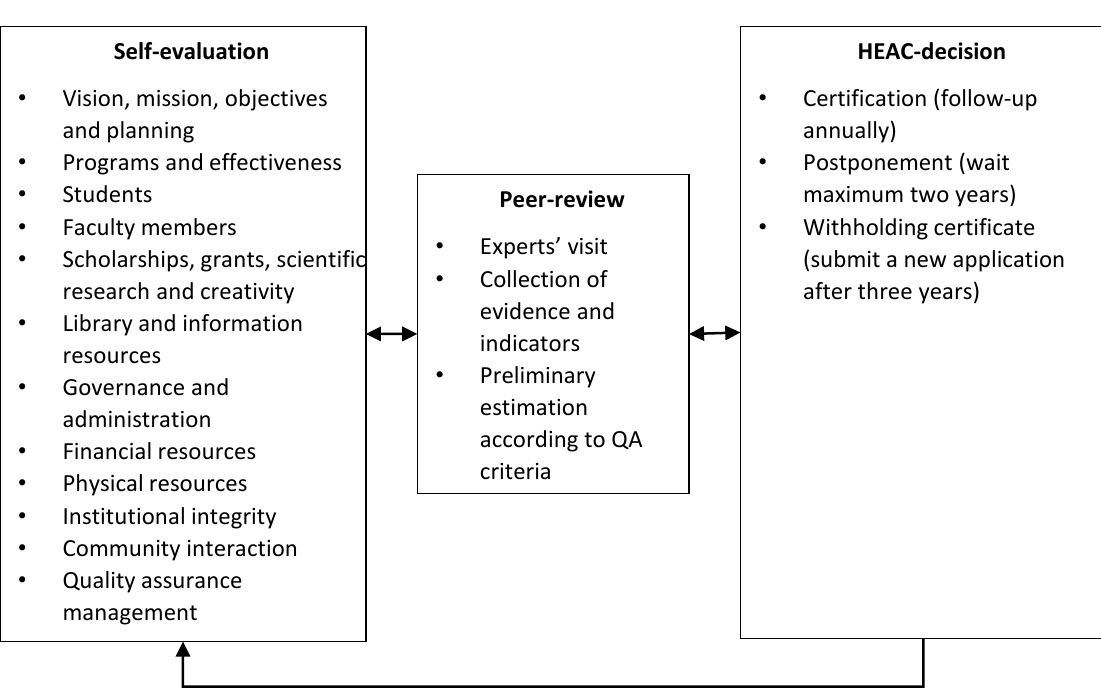
Figure 2): stage 1 – self-evaluation: information,